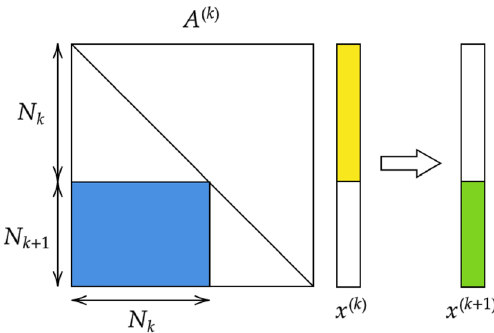
k ) , bridging layer k to layer k + 1 . The action